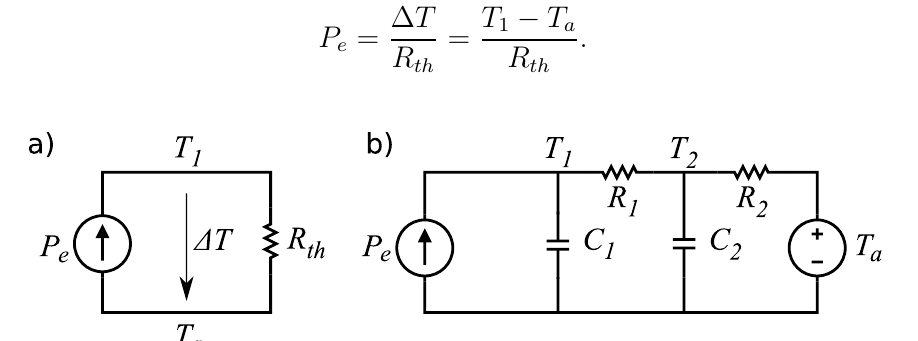
Figure 1. Two models of motor thermal behavior. ( a ) A simple steady-state model. ( b ) A more accurate thermal